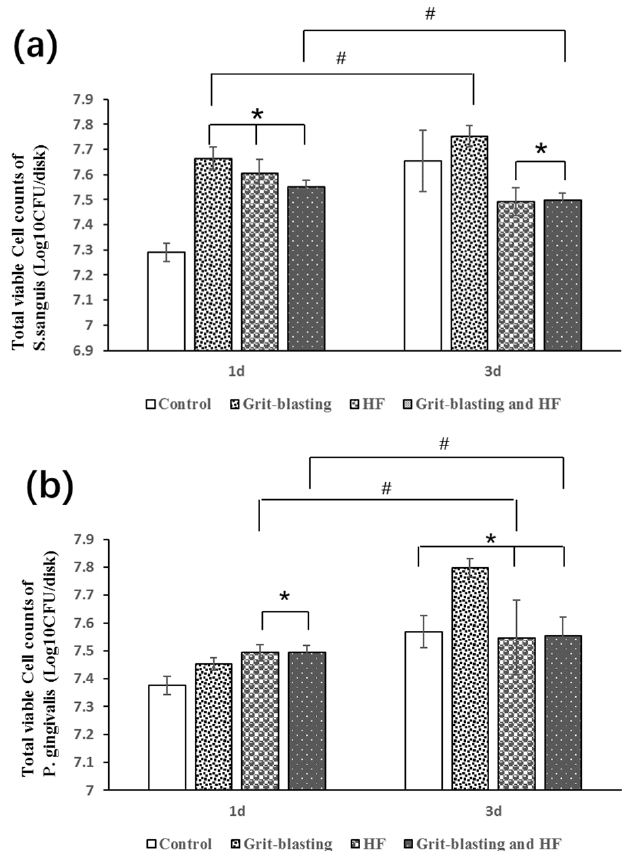
Figure 3. Changes of total viable CFU counts at the time point of day 1 and day 3 in biofilms: ( a ) S. sanguinis and ( b ) P. gingivalis. * denotes no statistically significant ( p > 0.05) difference between different groups among the same time point; # denotes no statistical significant difference ( p > 0.05) between the same groups among different time points.